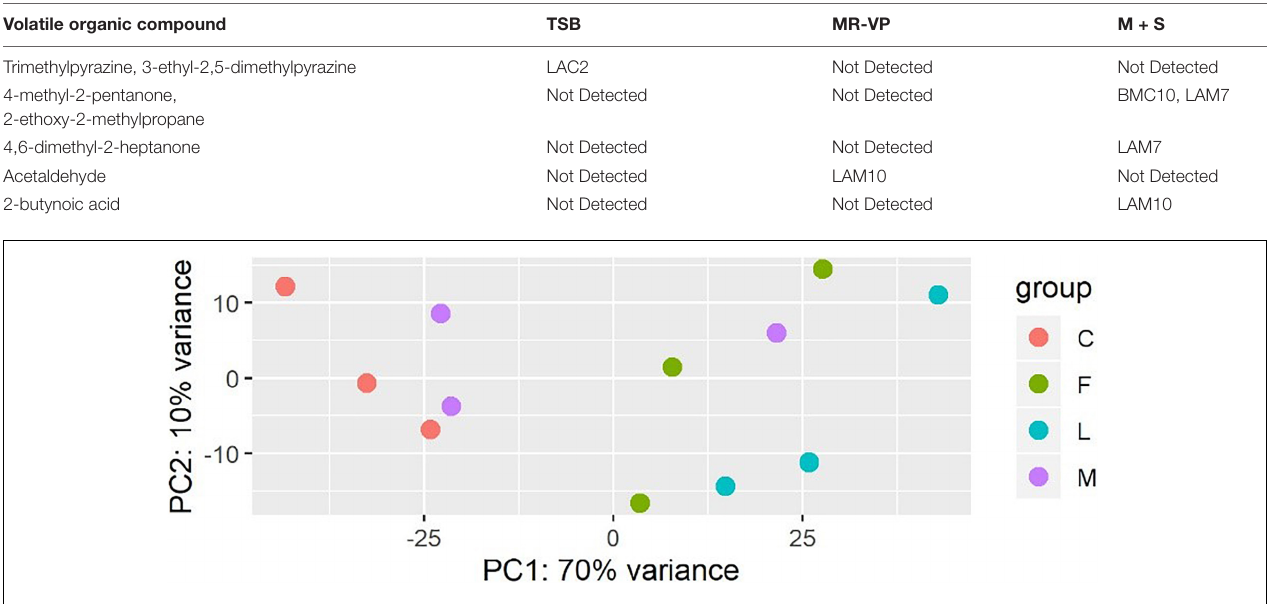
FIGURE 6 | Plot of the first two principal components of a PCA generated from the expression data (count data with variance stabilizing transformation from DeSeq2) colored by condition showing that samples in each condition group